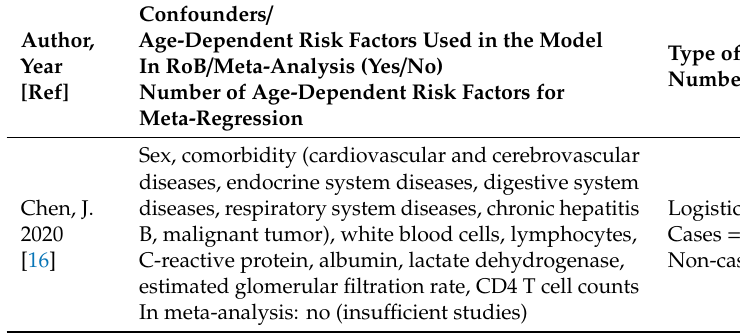
Table 5. Characteristics and results of included studies using admission to ICU as